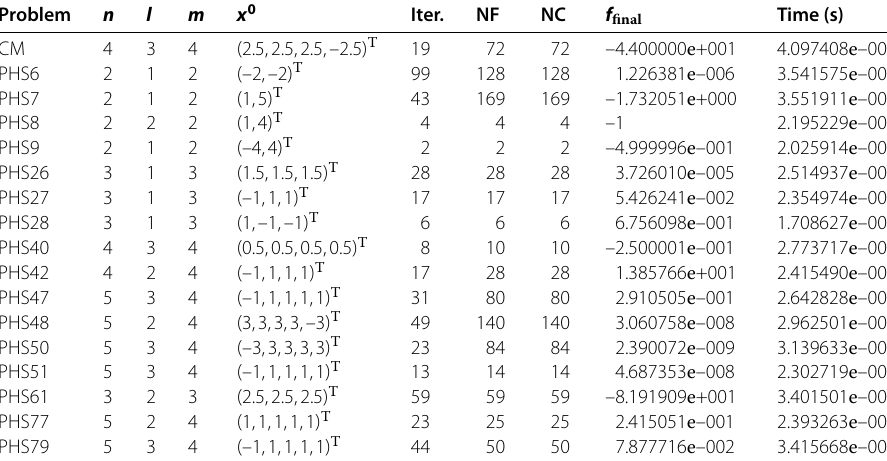
Table 1 The numerical results of test problems I and II